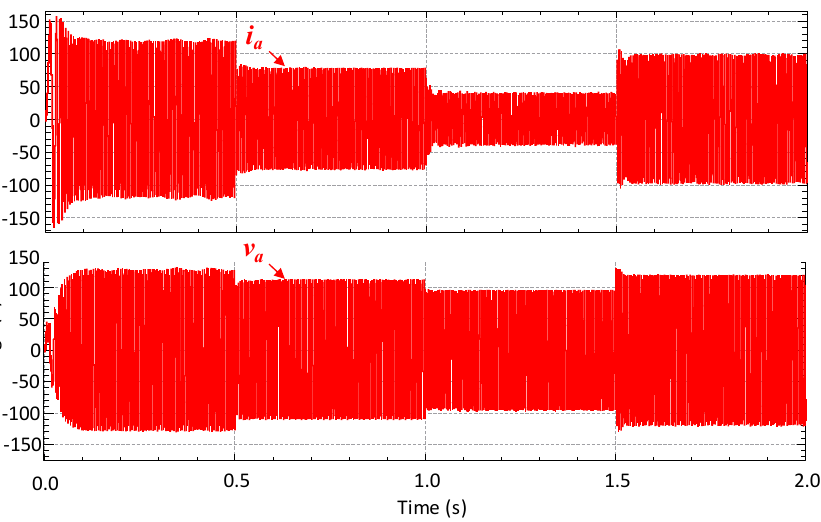
Figure 18. Simulation results of the stator winding current and voltage, in phase a , applied to the electric machine for different mechanical loads.